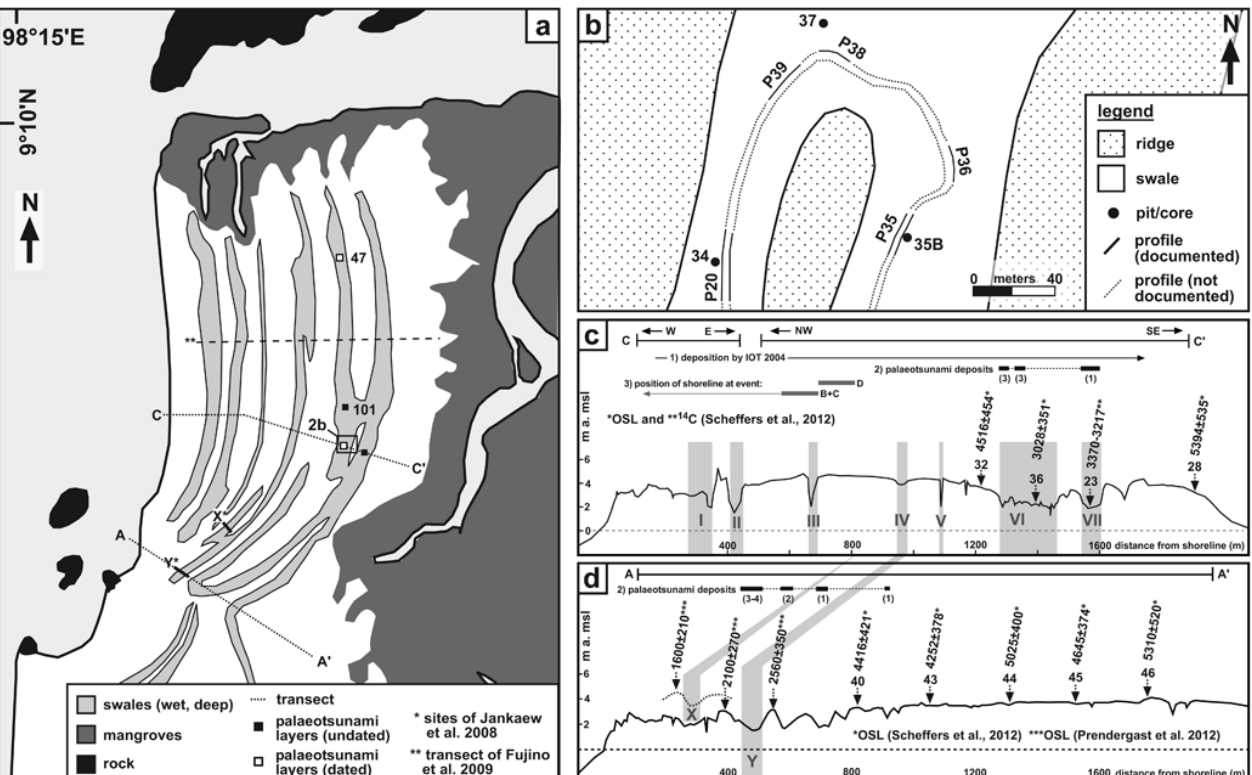
Fig. 2. Study area with sampling sites. (a) The north-western part of Phra Thong Island with the positions of deep and wet swales. Sampling sites of this and of previous studies are indicated. (b) Schematic overview of the southern section of swale VI (see a for exact location). (c) Topographical cross section in a west-east direction along transect C (C-C 0 in a ) with position of swale VI and chronological data of the neighbouring beach ridges (Scheffers et al., 2012). (d) Topographical cross section along transect A with beach-ridge ages from Prendergast et al. (2012) and Scheffers et al.